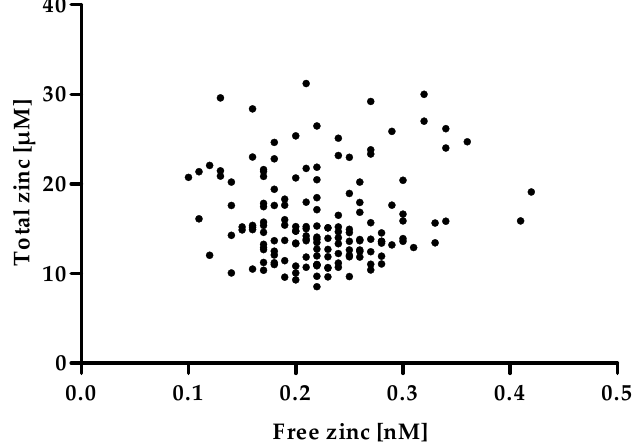
Figure 7. Correlation between free zinc and total zinc concentrations in human serum samples. The total zinc concentration was measured by inductively coupled plasma mass spectrometry (ICP-MS). Data represent values of a single determination. Free zinc concentration was measured using the method established above and represent means of n = 3 independent experiments. No significant correlation was found between total and free zinc concentration of the serum samples (Spearman rank correlation, α = 0.05).